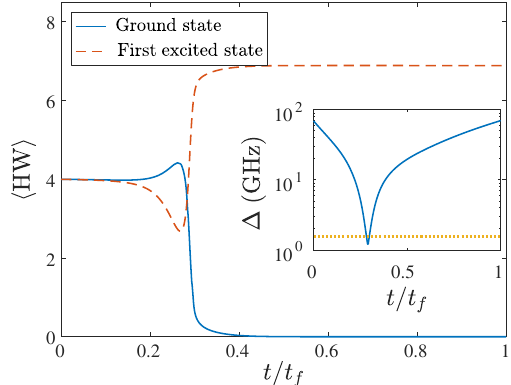
FIG. 4. Expectation values of the Hamming weight operator. Shown are the ground state and first excited state expectation P n values of HW ¼ 1 ð 1 − σ z Þ for the 8-qubit gadget using the 2 i i ¼ 1 DW2KQ annealing schedule. Inset: The ground state energy gap to the first excited state, as calculated using the DW2KQ annealing schedule. The dotted line corresponds to the operating temperature of the device.